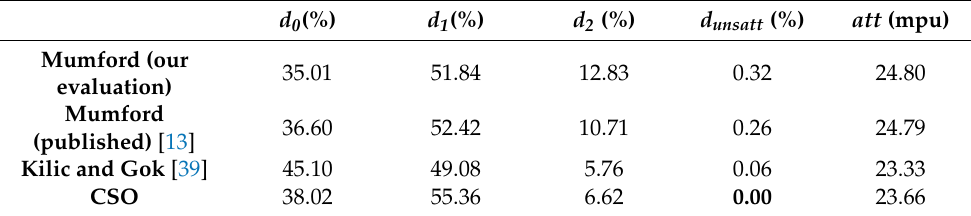
Table 14. Comparative results for the best solutions for Mumford1 network.